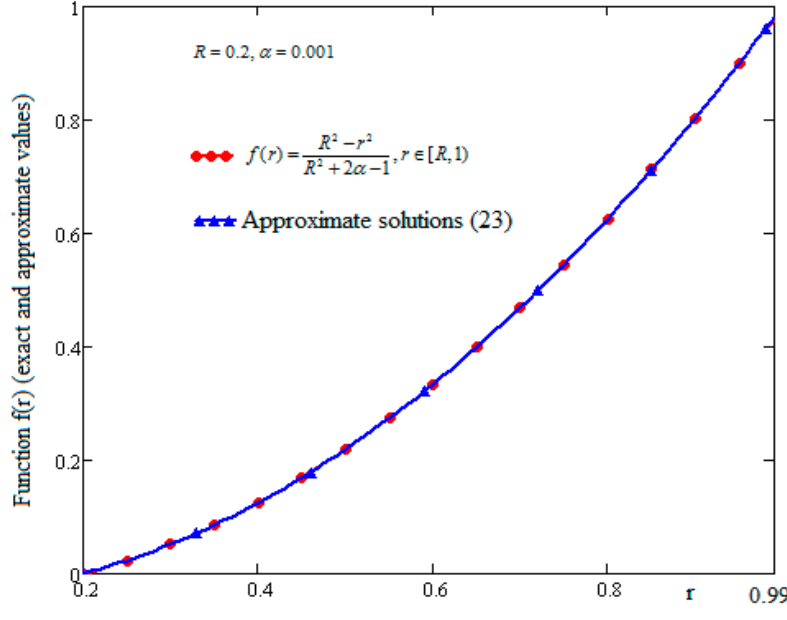
Figure 1. The profiles of function given by Equation (23).